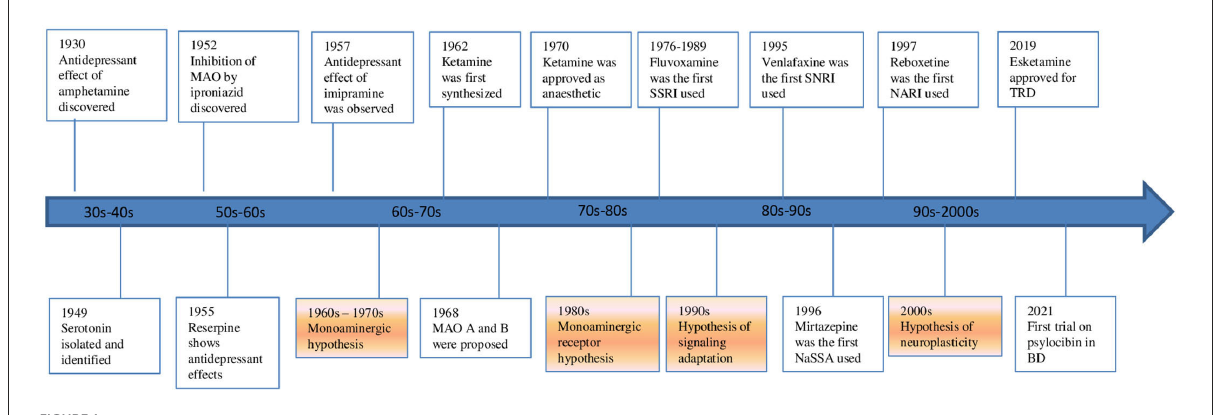
FIGURE1 Evolution of hypothesis and antidepressants in mood